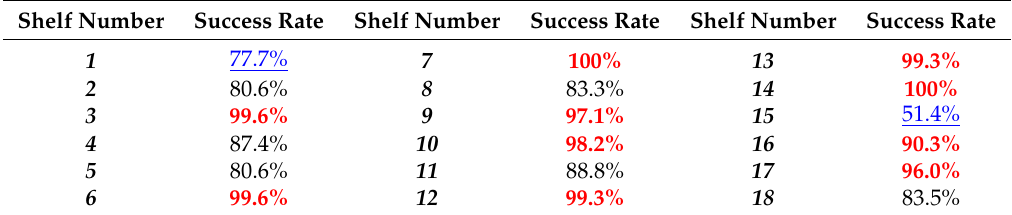
Figure 14. Average success rate for on-shelf availability for all the shelves at various error margins in experiment 3. Table 5. Success rate for each shelf at error margin of 0.10.